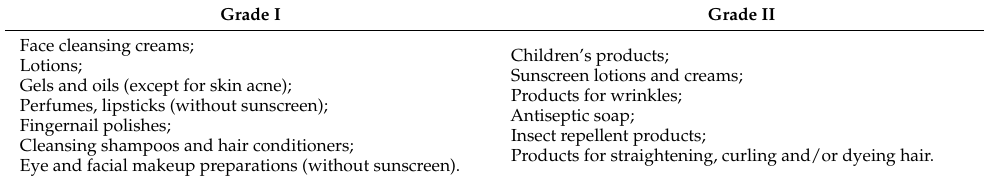
Table 3. Examples of cosmetics in Brazil, according to risk. Grade I Grade II